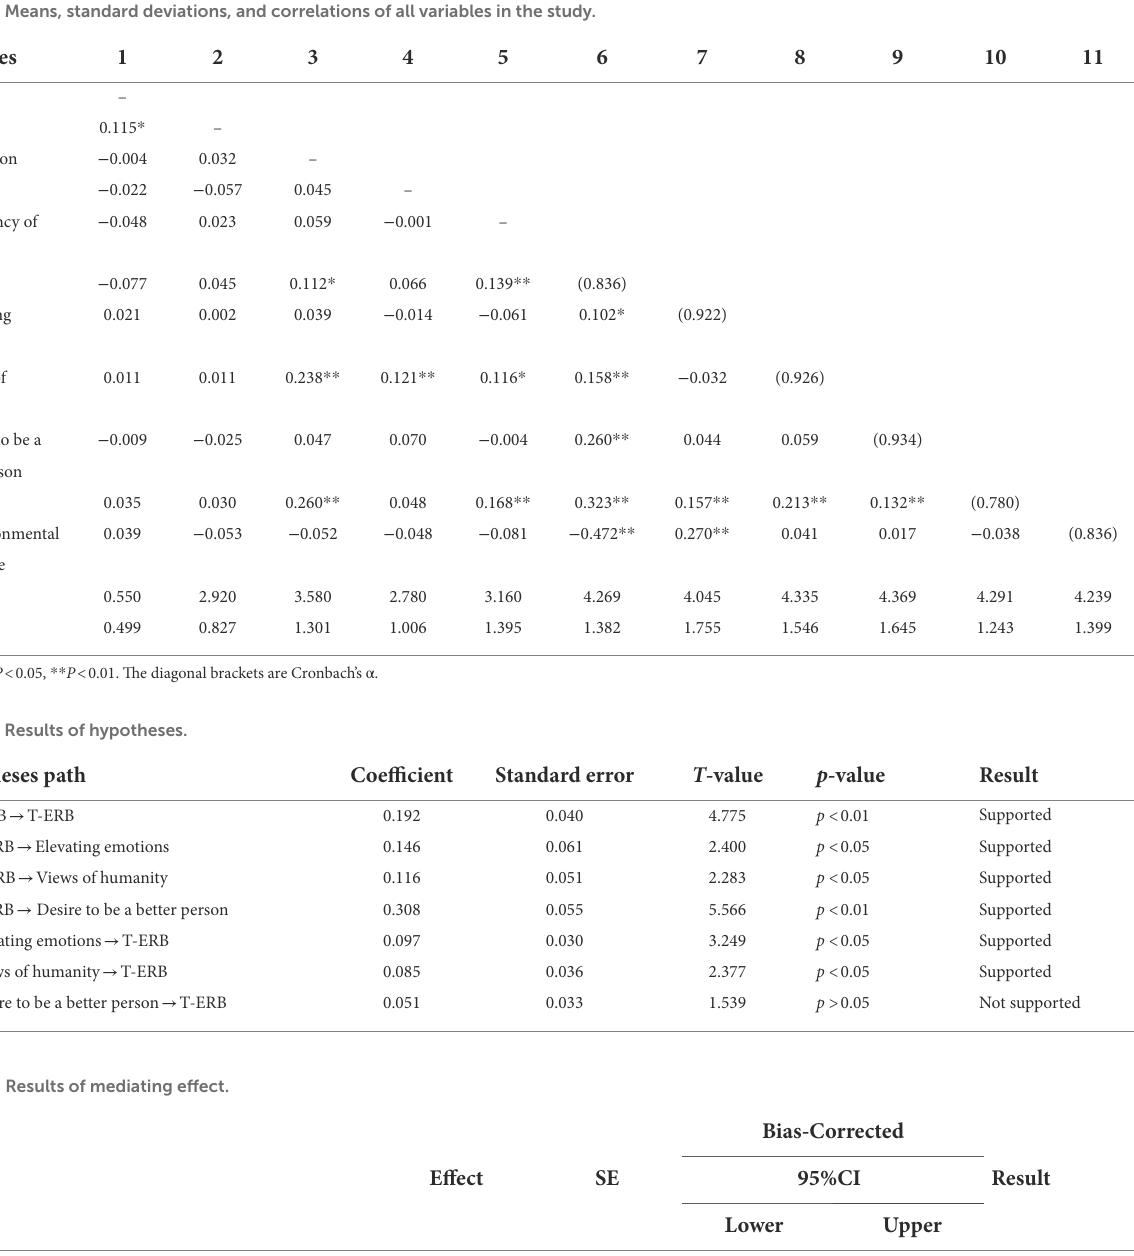
TABLE 2 Means, standard deviations, and correlations of all variables in the study.